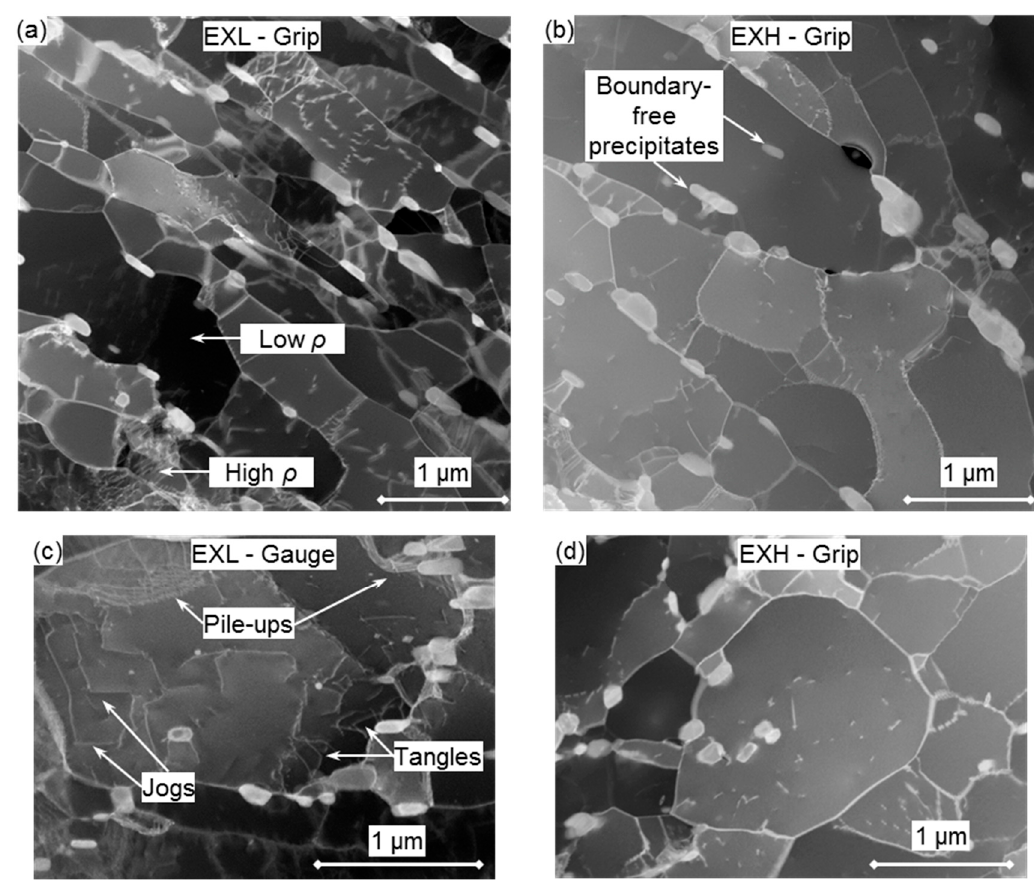
Figure 17. Annular Dark Field Scanning TEM (ADF-STEM) micrographs of ( a ) EXL, ( b ) EXH grip regions, ( c ) various dislocation interactions at the gauge center of EXL material, and ( d ) an equiaxed micro-grain in the EXH grip region. Regions of high and low concentrations of dislocations ρ are indicated in ( a ).